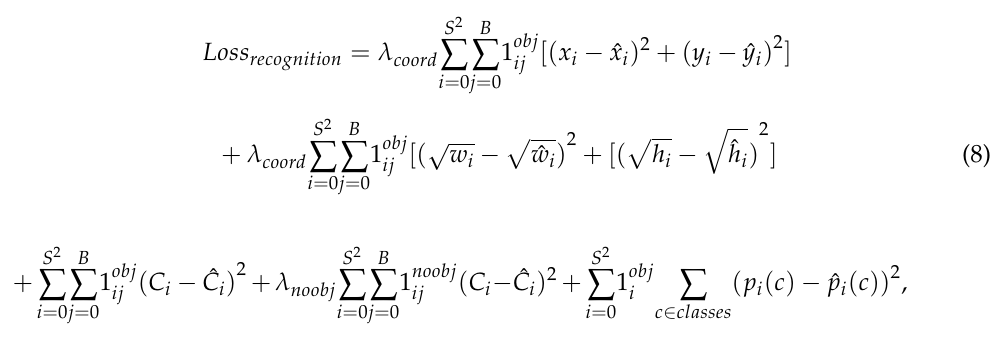
Figure 7. Flowchart of gradual end-to-end learning method. ( a ) Step 1: Independent training of the SR module and LP recognition module. ( b ) Step 2: SR module training while freezing LP recognition module. ( c ) Step 3: LP recognition module training while freezing SR module. “GT” denotes ground truth. “Pred” denotes the prediction result. Algorithm 3. A pseudocode of the gradual end-to-end learning method based on weight freezing.